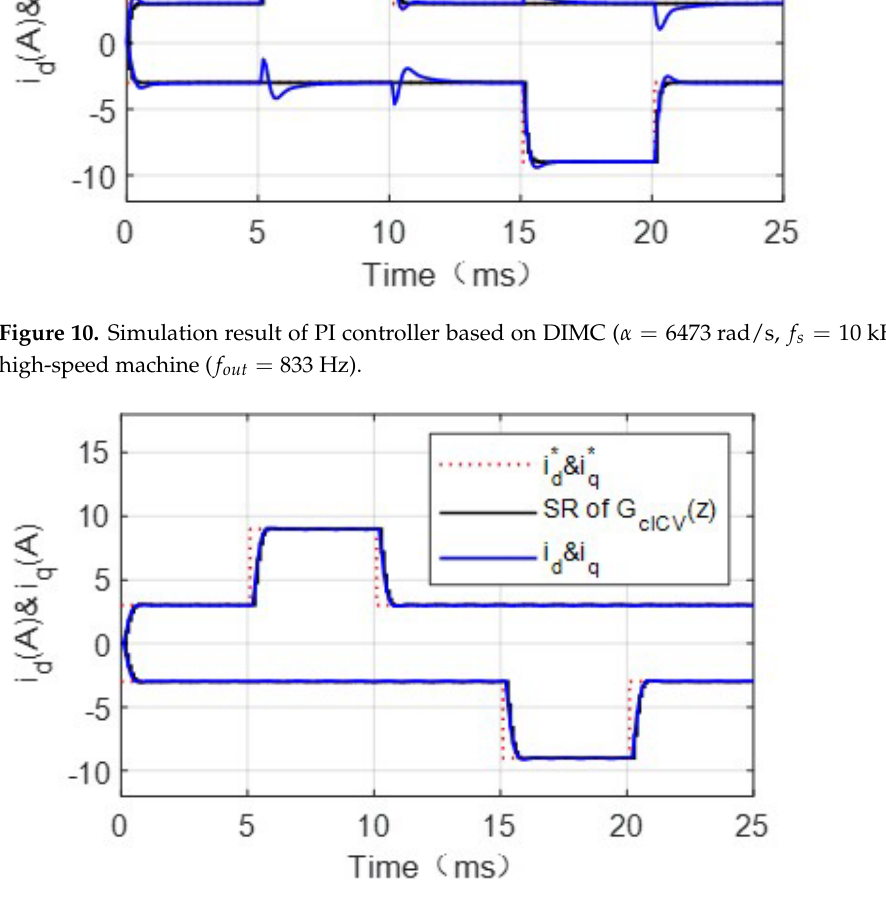
Figure 11. Simulation result of complex vector controller based on flux-linkage data ( k = 0.3, f s = 10 kHz) of the high-speed machine ( f out = 833